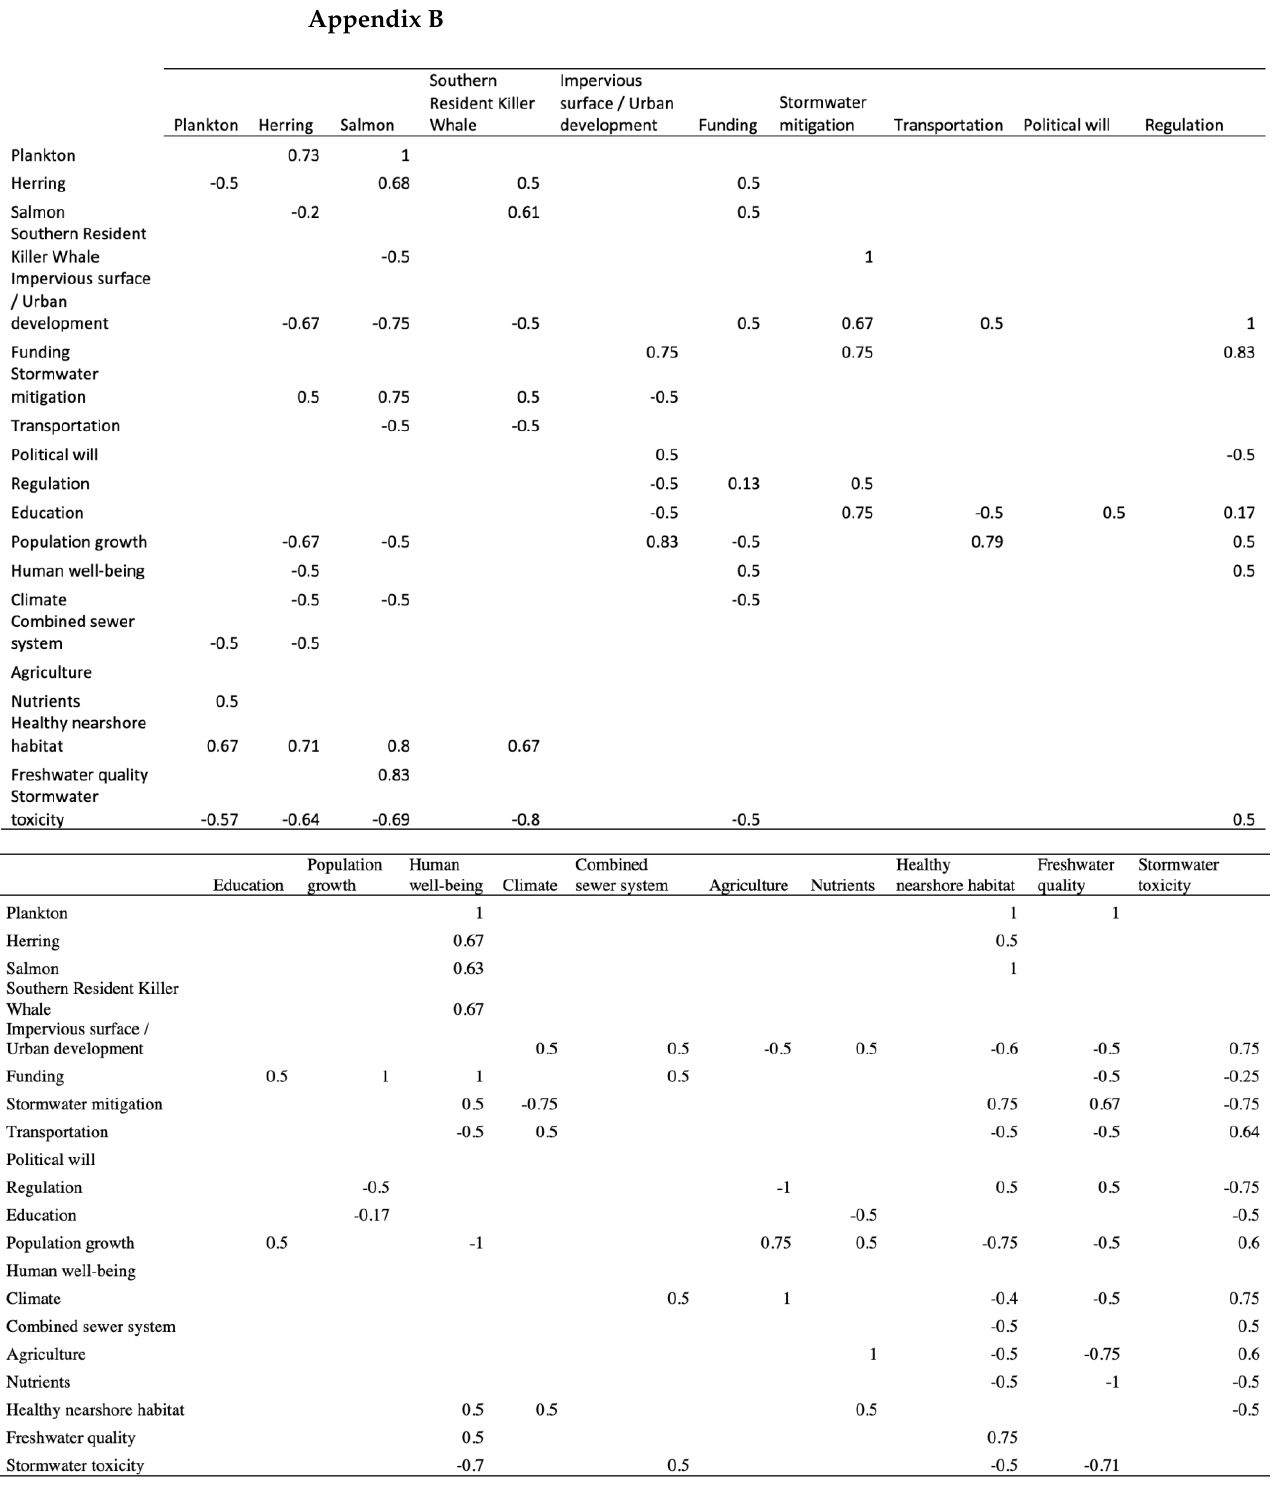
Figure A1. Matrix representation of the aggregate mental model of the Puget Sound stormwater social–ecological system shown in Figure 2. The aggregate model integrates information from all experts interviewed in the study. Numbers represent interaction strengths between nodes in the mental model and were estimated by averaging interaction strengths from individual mental models. See methods for more details.